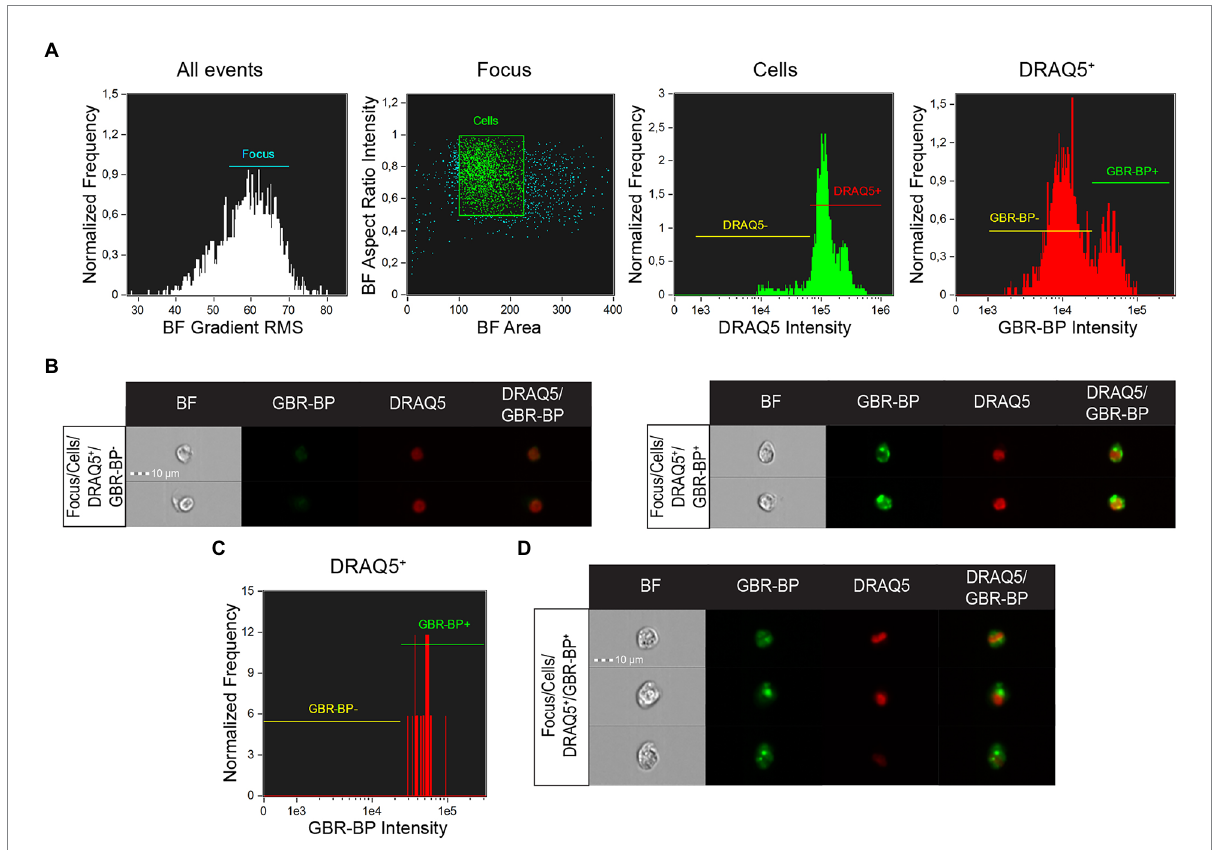
FIGURE 5 Assessing the sorting efficiency of double-stained (DRAQ5 + /GBR-BP + ) cell population by imaging flow cytometry. (A) Characteristic of the total cell suspension of substantia nigra (SN) vibratome sections pre-stained with DRAQ5 and GBR-BP ( n = 1). (B) Images of cells from the total cell suspension of SN vibratome sections pre-stained with DRAQ5 and GBR-BP. (C) Population of DRAQ5 + /GBR-BP + cells sorted from the total cell suspension ( n = 1). (D) Images of DRAQ5 + /GBR-BP + cells sorted from the total cell suspension. BF, bright field; RMS, root mean